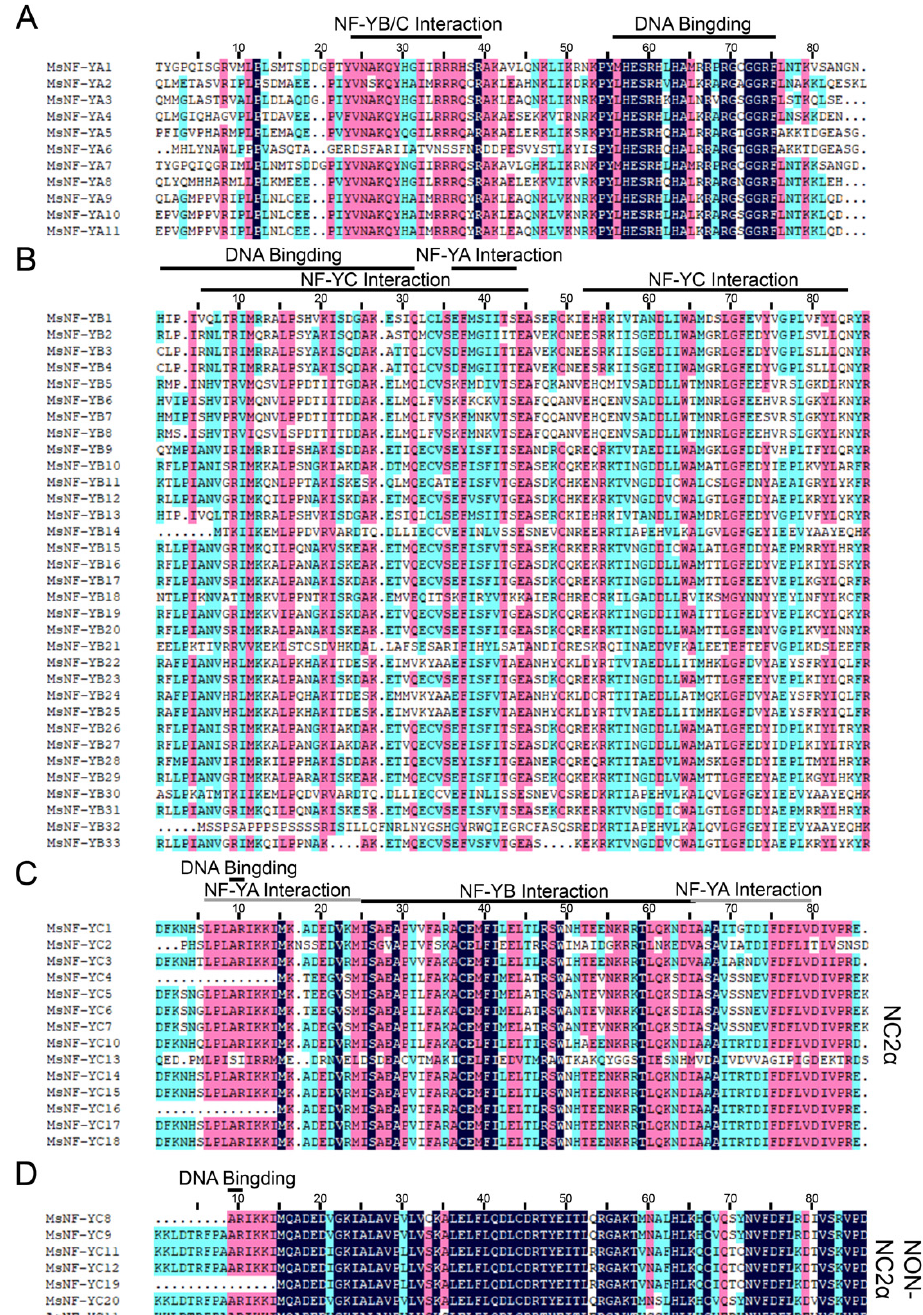
Figure 3. The multiple sequence alignments of ( A ) MsNF-YA, ( B ) MsNF-YB, ( C ) non-MsNC2 α and ( D ) MsNC2 α . Black and grey lines show the interaction and binding domains of MsNF-Y proteins.